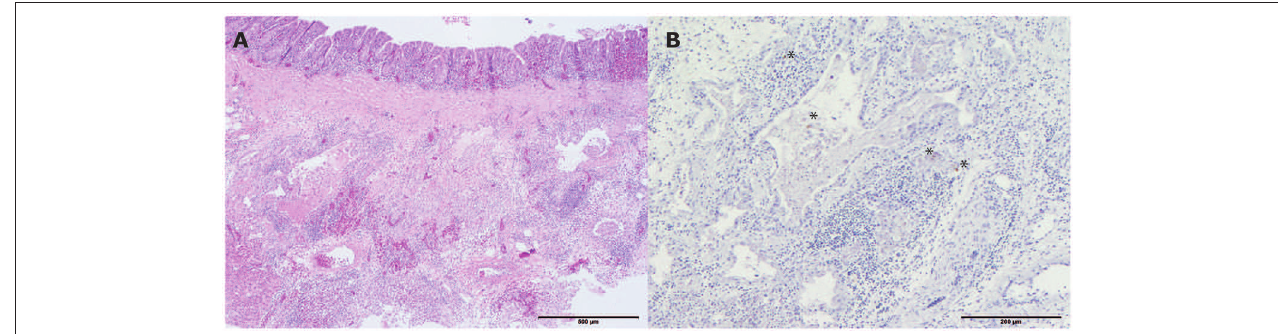
FIGURE 4 | Histopathologic and immunohistochemical (IHC) testing results of a lung from one of the living hens that were submitted for pathological examination. (A) Mild pneumonia consisting of collapse of multiple atria and capillaries by moderate infiltrates of mainly macrophages, lymphocytes, less heterophils and fibrinous and necrotic debris with organization (hematoxylin and eosin (H&E) stain). Bar < 500 µ m; (B) Influenza A virus antigen within the mononuclear infiltrate scattered cells. Bar < 200 µ m. *indicates the colored cells.